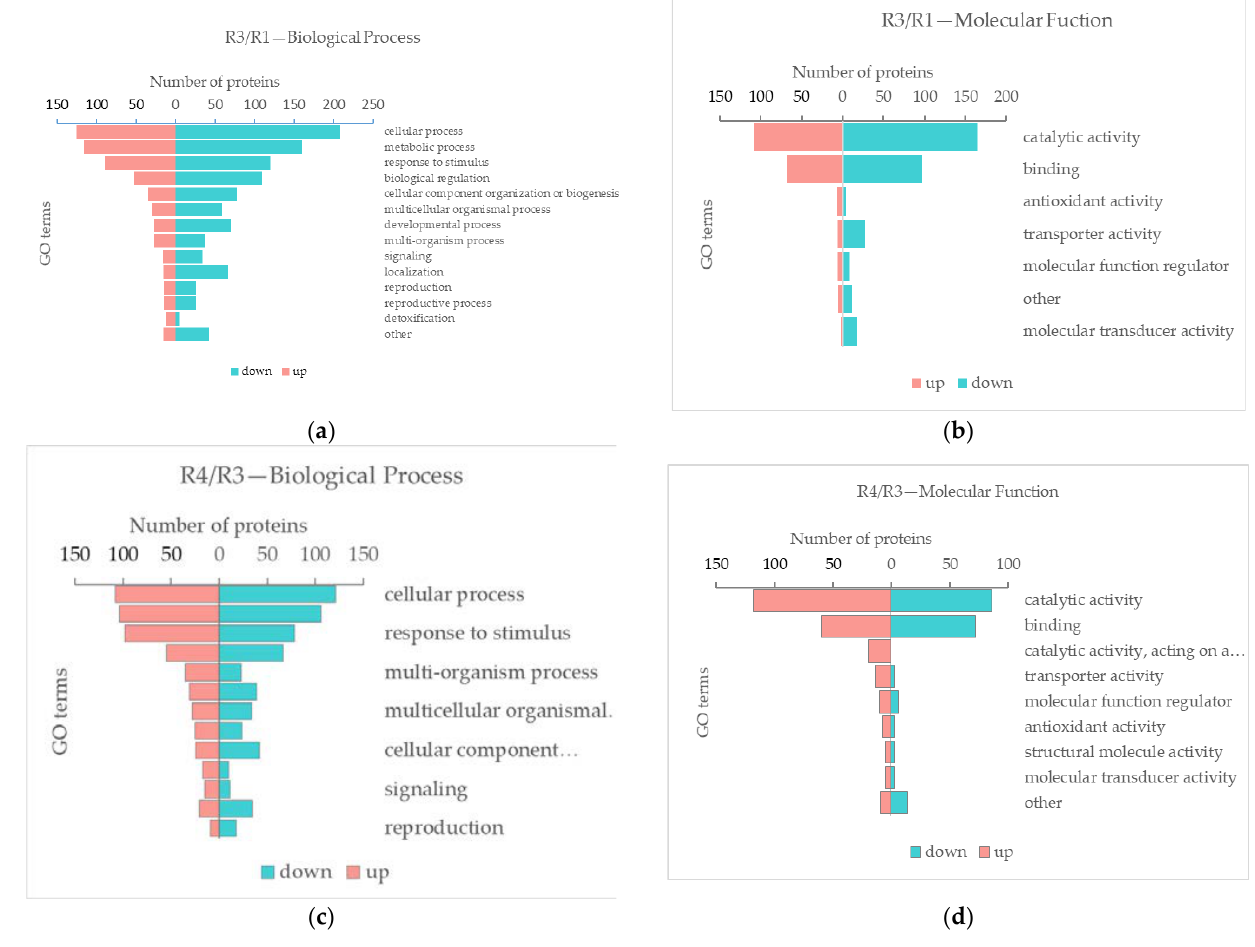
Figure 4. GO classification. ( a ) GO (Biological Process) classification of DEPS in R3/R1. ( b ) GO (Molecular Function) classification of DEPS in R3/R1. ( c ) GO (Biological Process) classification of DEPS in R4/R3. ( d ) GO (Molecular Function) classification of DEPS in R4/R3.